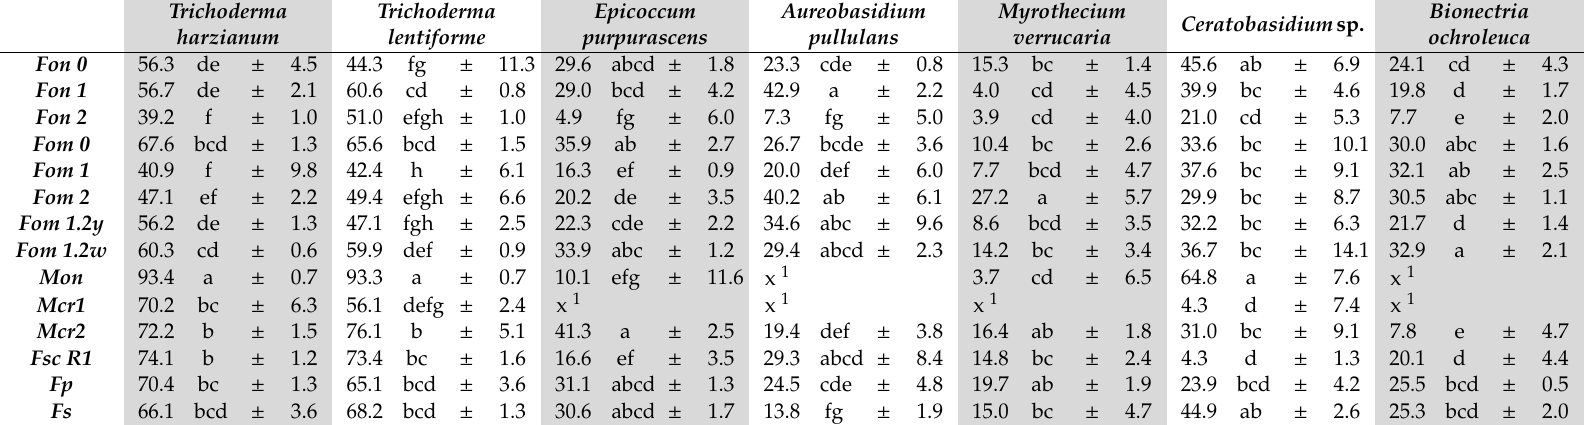
Table 2. Average values of the percentage of radial growth inhibition (PRGI) (mean ± standard deviation) obtained in each dual plate confrontation for 14 pathogens and 7 antagonists, after 10 days of culture.